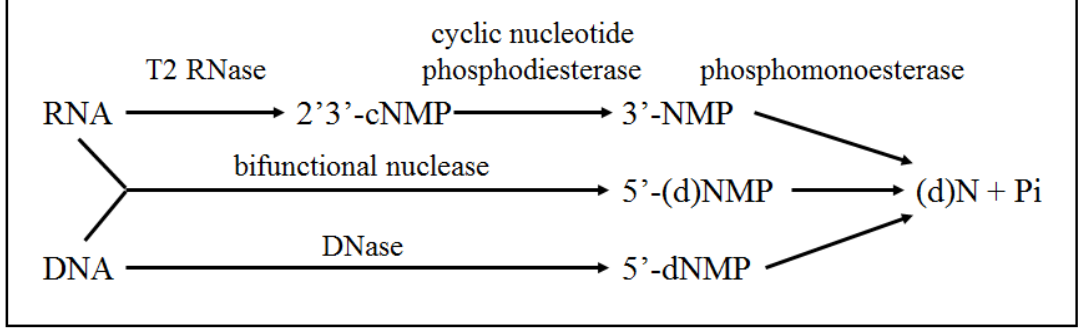
Figure 2. Model of nucleic acid degradation and Pi recycling by nucleolytic enzymes (modified from